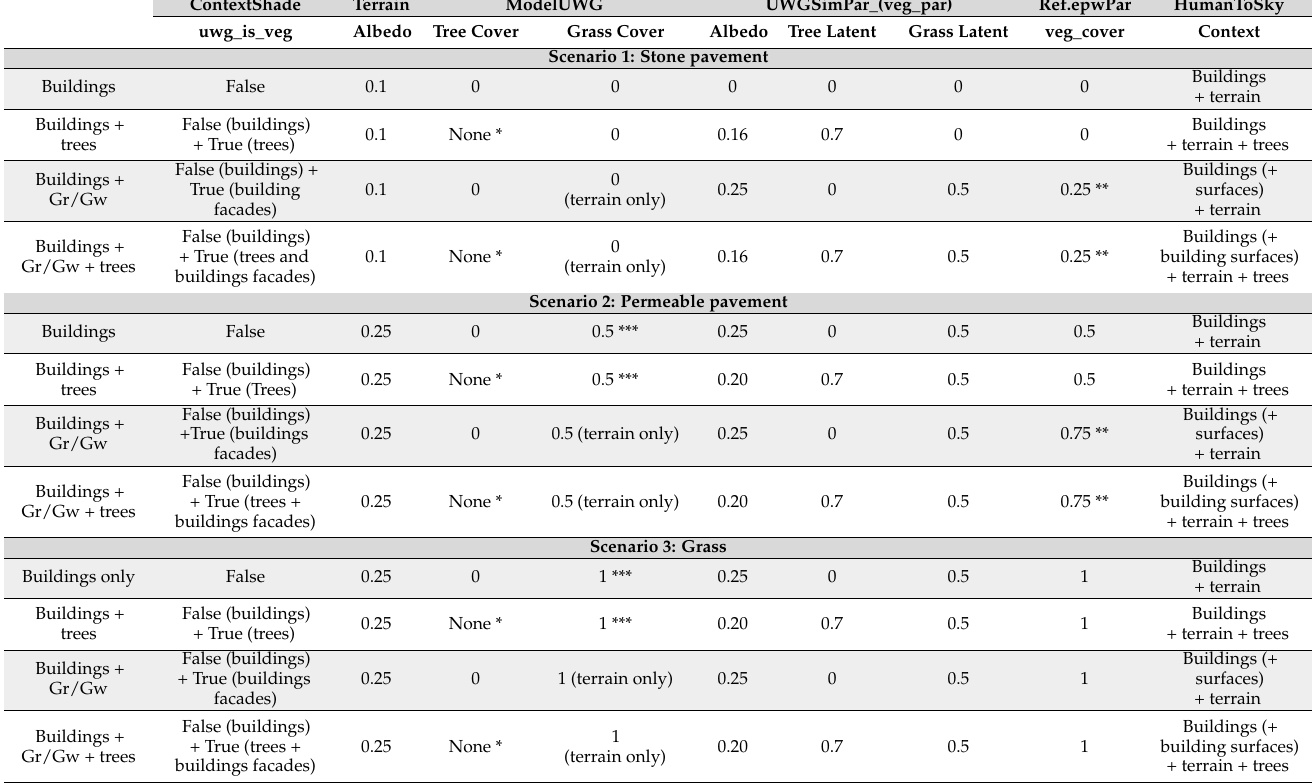
Table 1. Workflow components and